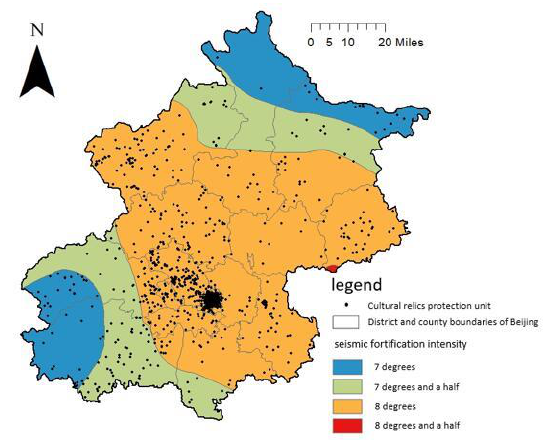
Figure 9. Seismic Intensity and Seismic Fault Distribution of Beijing's Cultural Heritage Units.